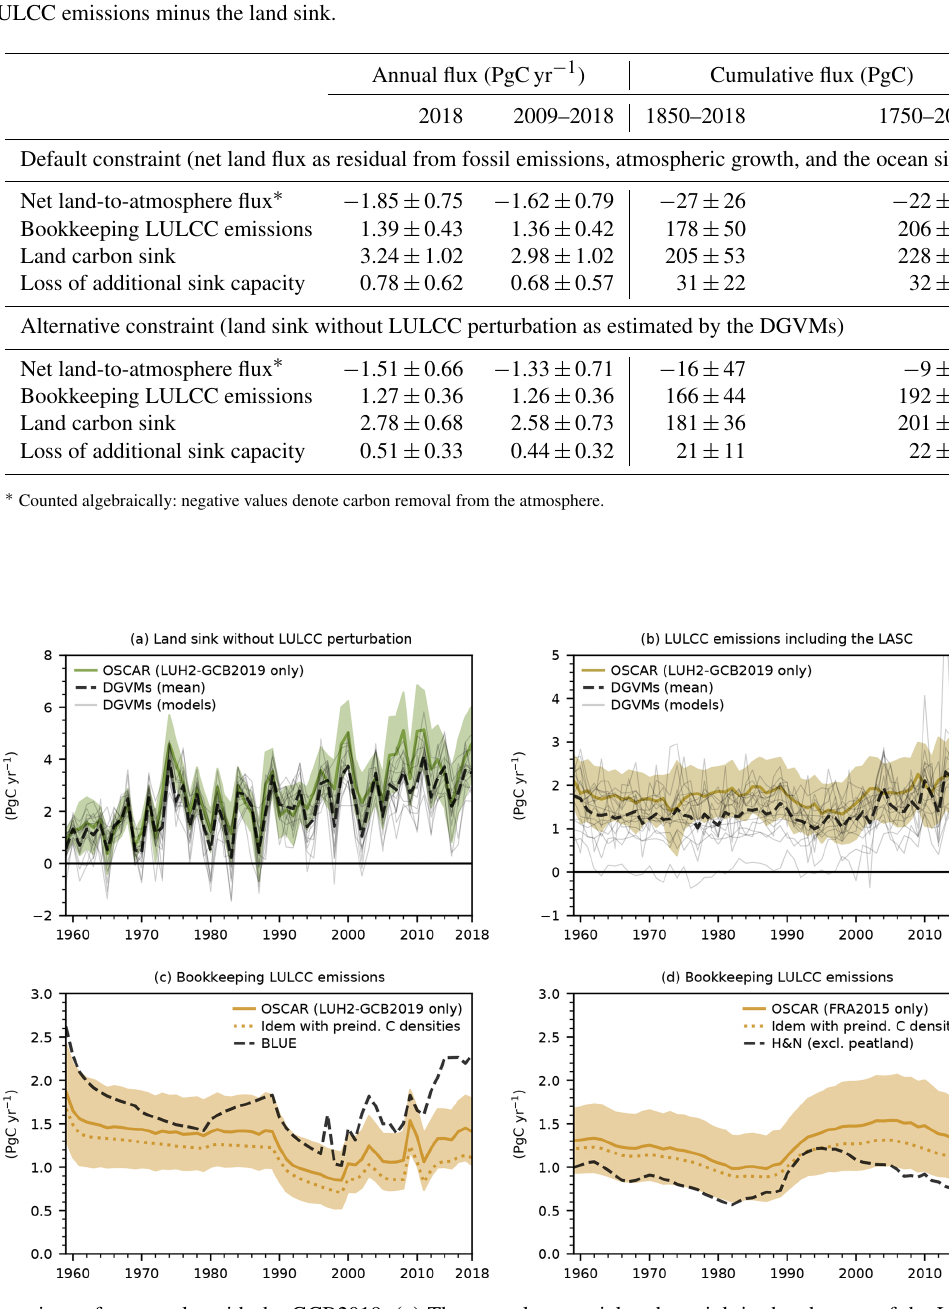
Figure 2. Comparison of our results with the GCB2019. (a) The annual terrestrial carbon sink in the absence of the LULCC perturbation simulated by OSCAR (color), the individual GCB DGVMs (light gray), and their multi-model mean (dashed black). (b) The annual LULCC emissions deduced from the GCB DGVMs (i.e., including the LASC). (c) Bookkeeping LULCC emissions when the model is driven by the LUH2-GCB2019 data set compared with BLUE estimates reported by the GCB2019. The dotted line shows the same emissions but when carbon densities are kept at their preindustrial level throughout the simulation (shown without uncertainty for legibility). (d) Bookkeeping LULCC emissions when the model is driven by the FRA2015 data set compared with the H&N estimates from which emissions from peatlands were subtracted. All shaded areas show the 1 σ uncertainty range. “Idem” stands for “same as